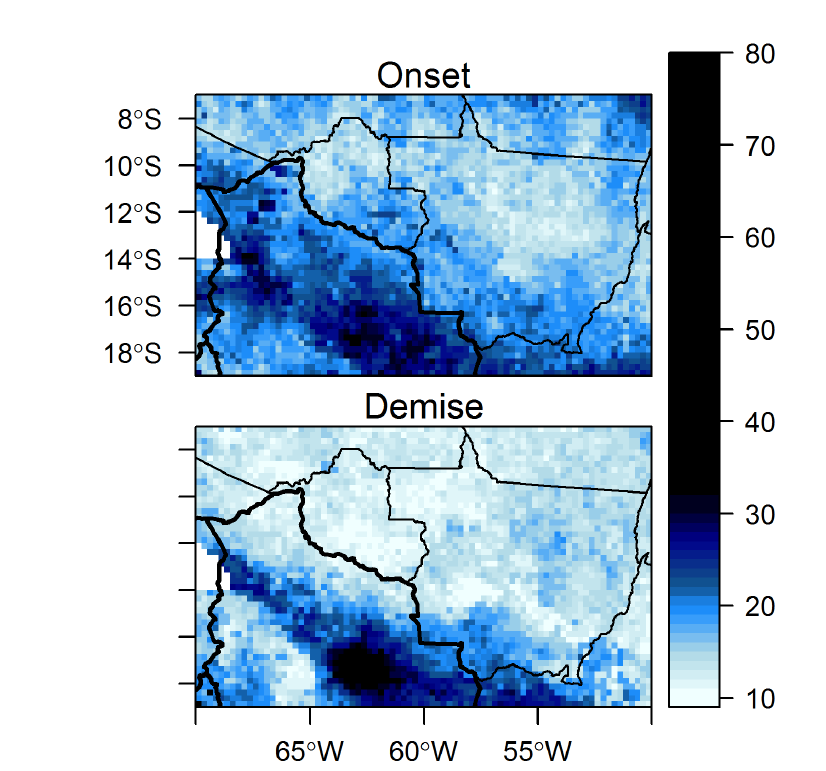
Figure 8. Standard deviation (in days) of onset and demise dates of the rainy season in the southern